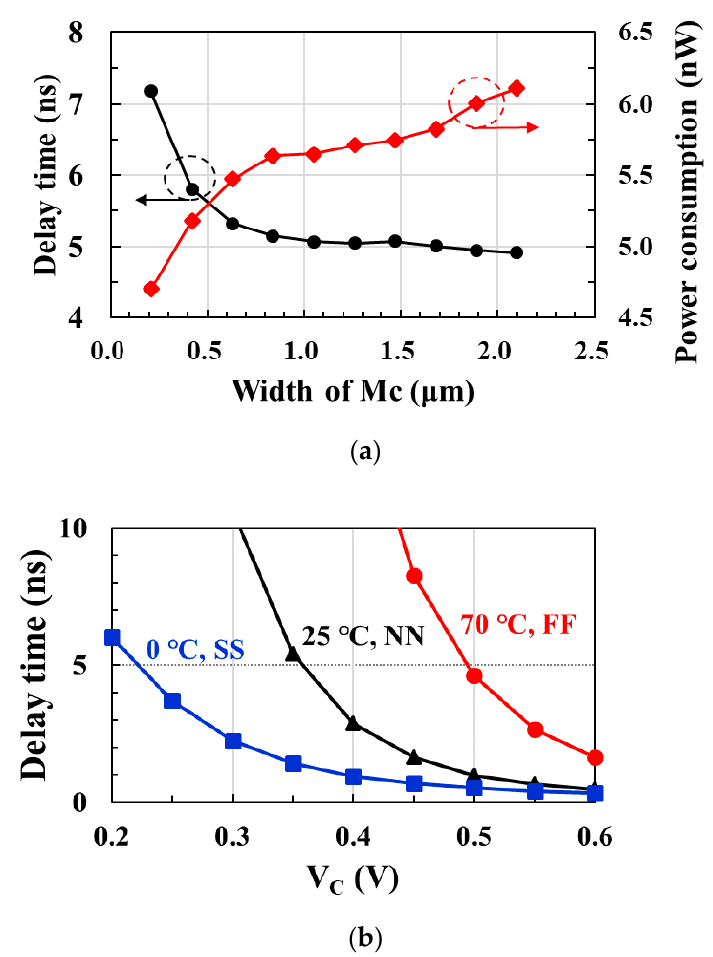
Figure 7. ( a ) Delay time and power consumption of the delay stage according to the width of Mc ; ( b ) delay time with control voltage V C at different corner models and temperature conditions.